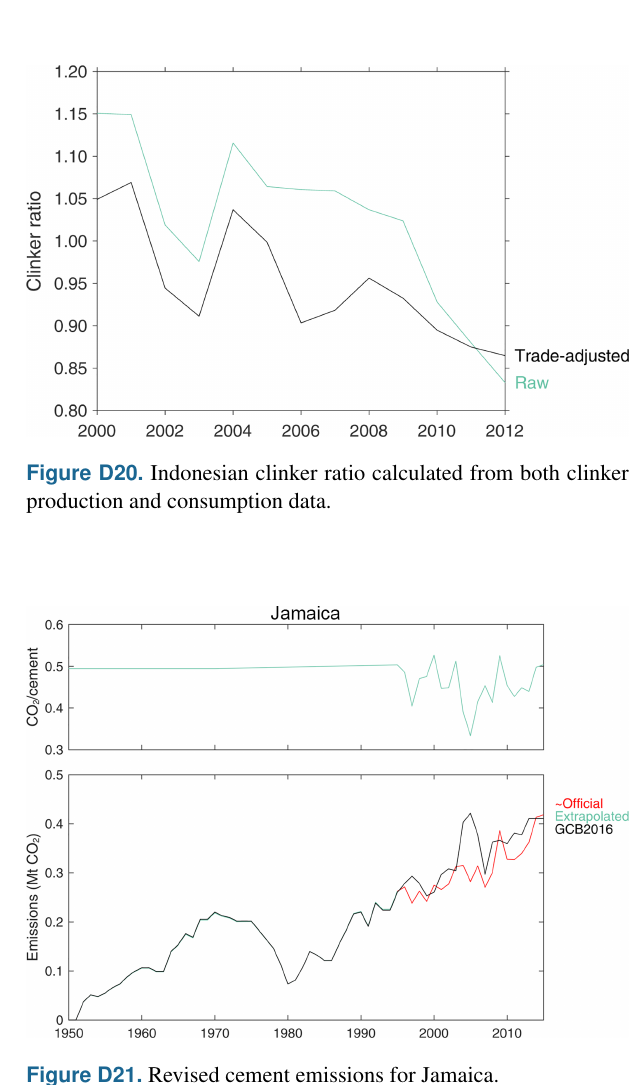
Figure D22. Revised cement emissions for South Korea.